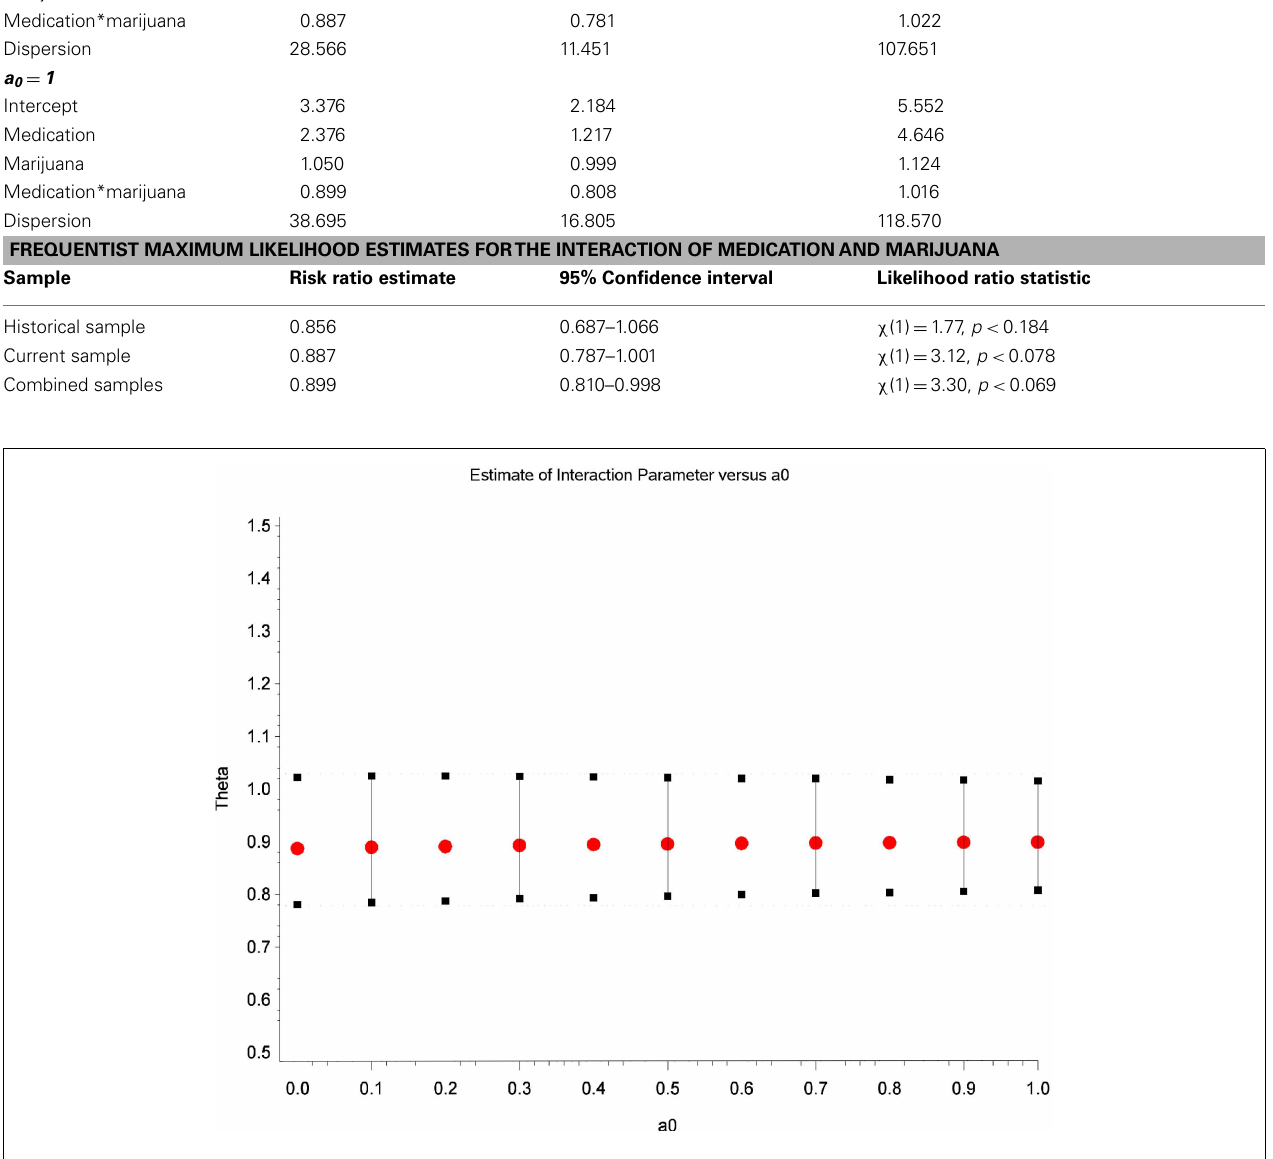
FIGURE 1 | Estimates of the parameter for the interaction term (i.e., theta) as a function of different values of a 0